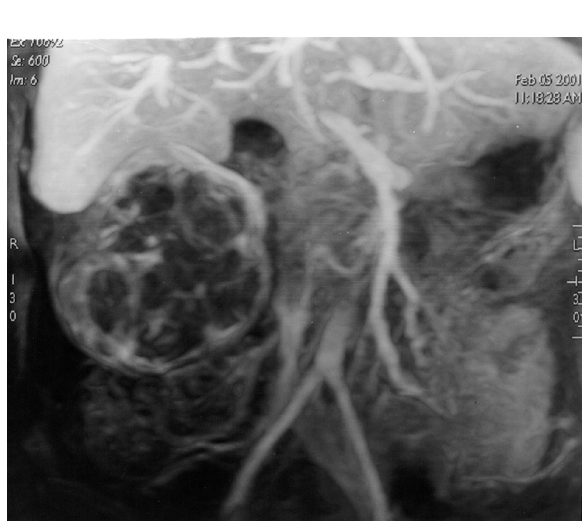
Figure 1 - Angio-MRI demonstrating renal mass and thrombo- sis of the right renal vein.